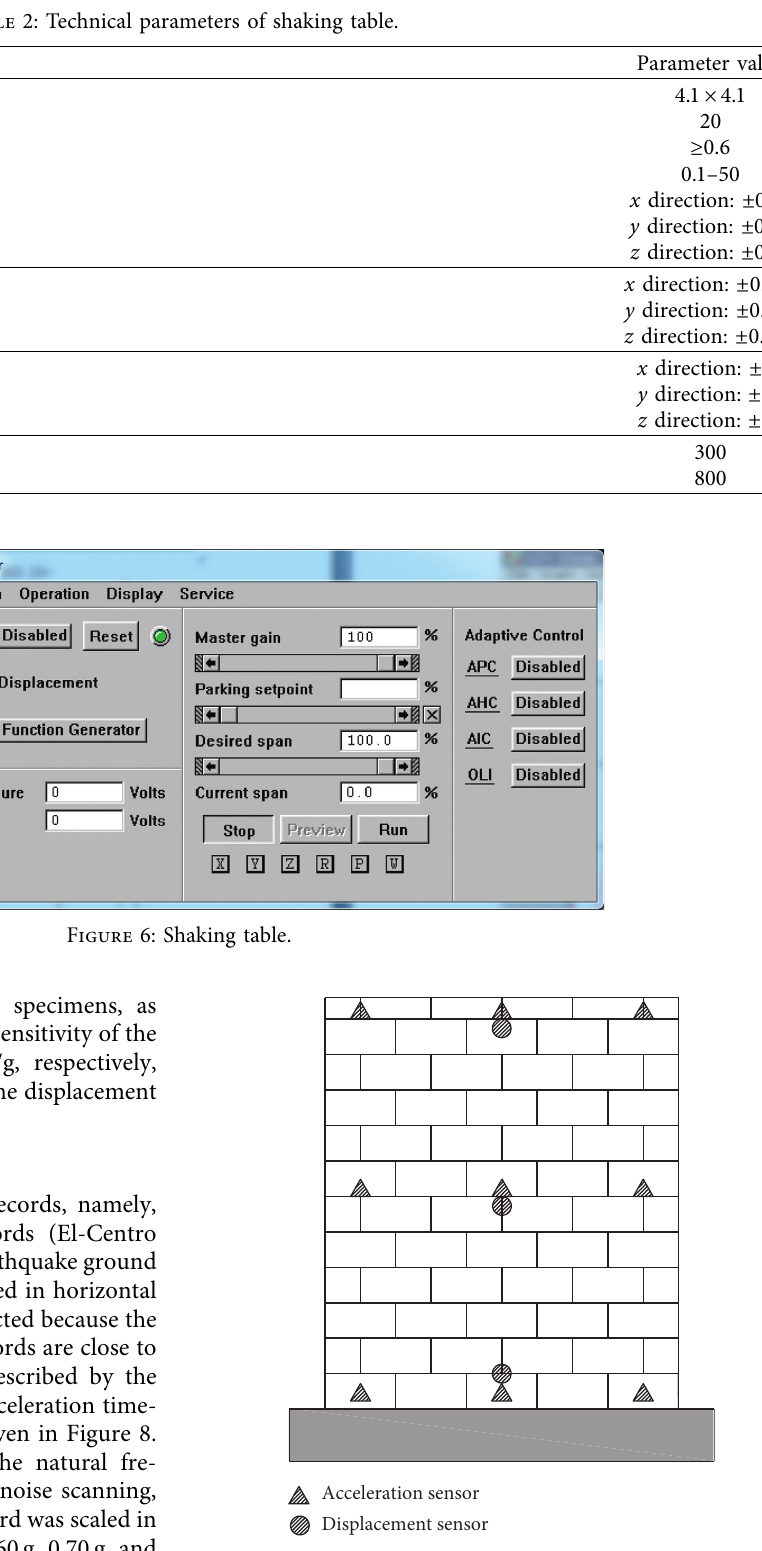
Figure 7: Instrumentation